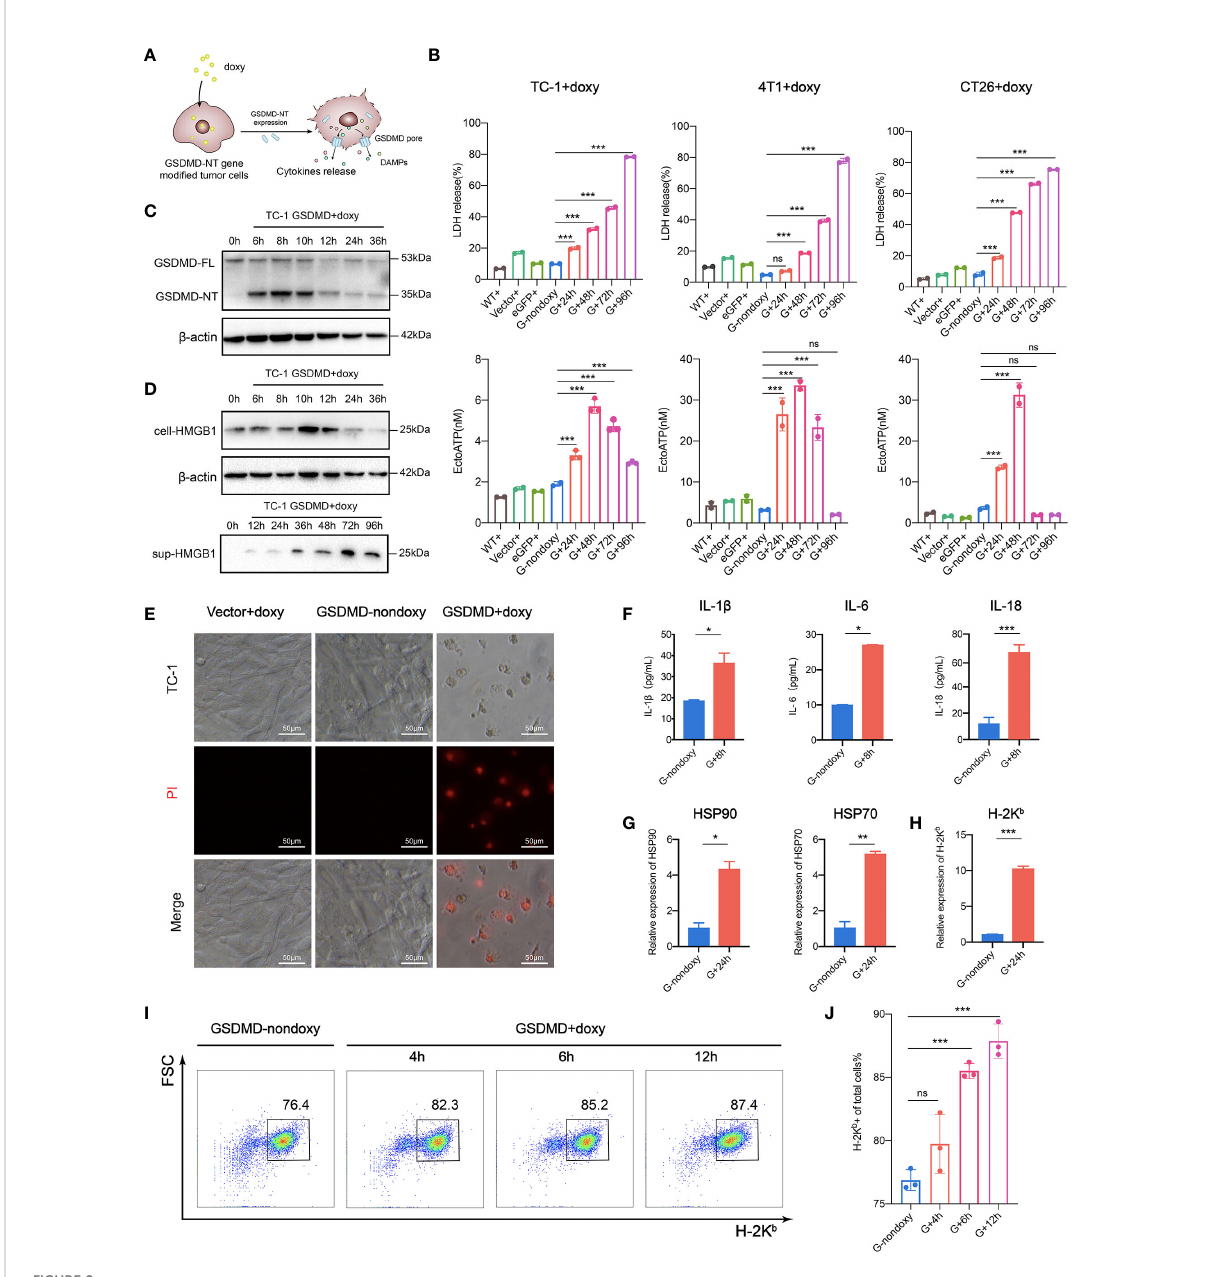
FIGURE 2 Expression and release of immune mediators in pyroptotic tumor cells. (A) Pattern diagram of immunogenic pyroptosis induced by Tet-On- GSDMD-NT gene expression. (B) The release of LDH (upper) and ATP (lower) was detected during the process of pyroptosis induction. WT+, Vector+, eGFP+ served as a homotype control to eliminate the nonpyroptotic effects of doxy on cells, and G-nondoxy served as a blank control. (C, D) Western blotting showing the expression of GSDMD-NT and (D) the expression and release of HMGB1 was induced in genetically modi fi ed TC-1 cells by doxy. (E) PI uptake assays. The modi fi ed TC-1 cells were incubated with doxy for 48 h and observed under a fl uorescence microscope 6 h after PI dye was added. Scale bar, 50 m m. (F) The release of in fl ammatory cytokines in the supernatant of pyroptotic tumor cells was detected by ELISA (n=3). (G, H) The expression of HSP70, HSP90 and (H) H-2K b in the modi fi ed TC-1 cells was analyzed by RT-qPCR (n=3). (I, J) Representative fl ow cytometry pseudocolor dotplots and (J) histogram analysis of H-2K b expressing cells (n=3) in the dynamic pyroptosis process of the modi fi ed TC-1 cells. Graph shows means ± SD; (B, J) One-way ANOVA; (F, G, H) unpaired Student ’ s t test, * p value < 0.05, ** p value < 0.01, *** p value < 0.001, ns represents no signi fi